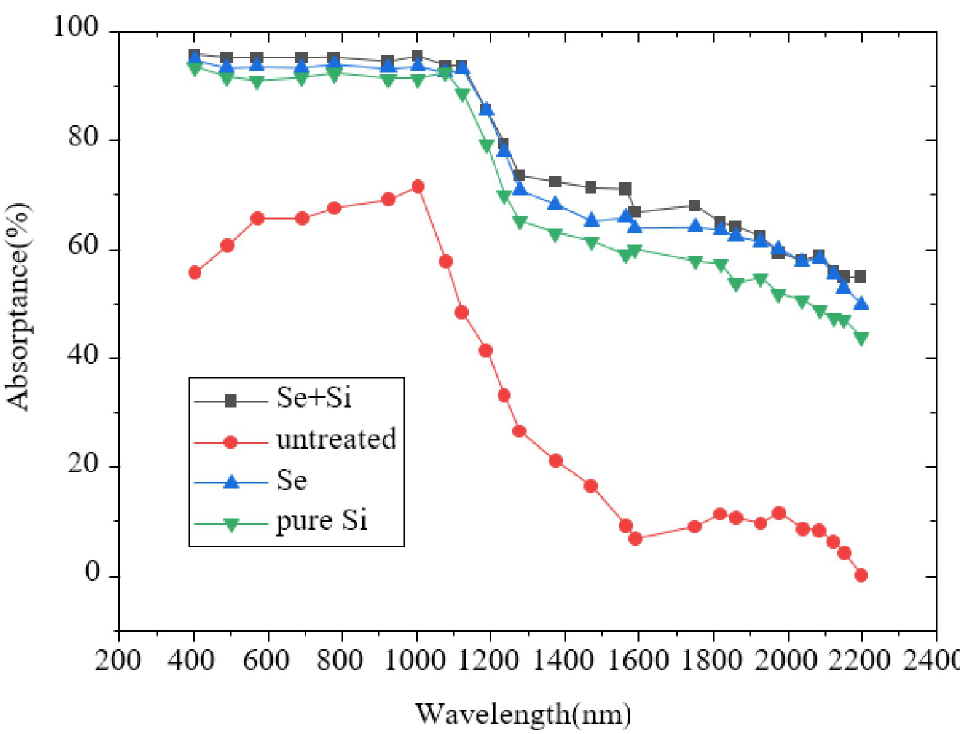
Fig 7. Comparison of absorption spectra of different film samples after FS